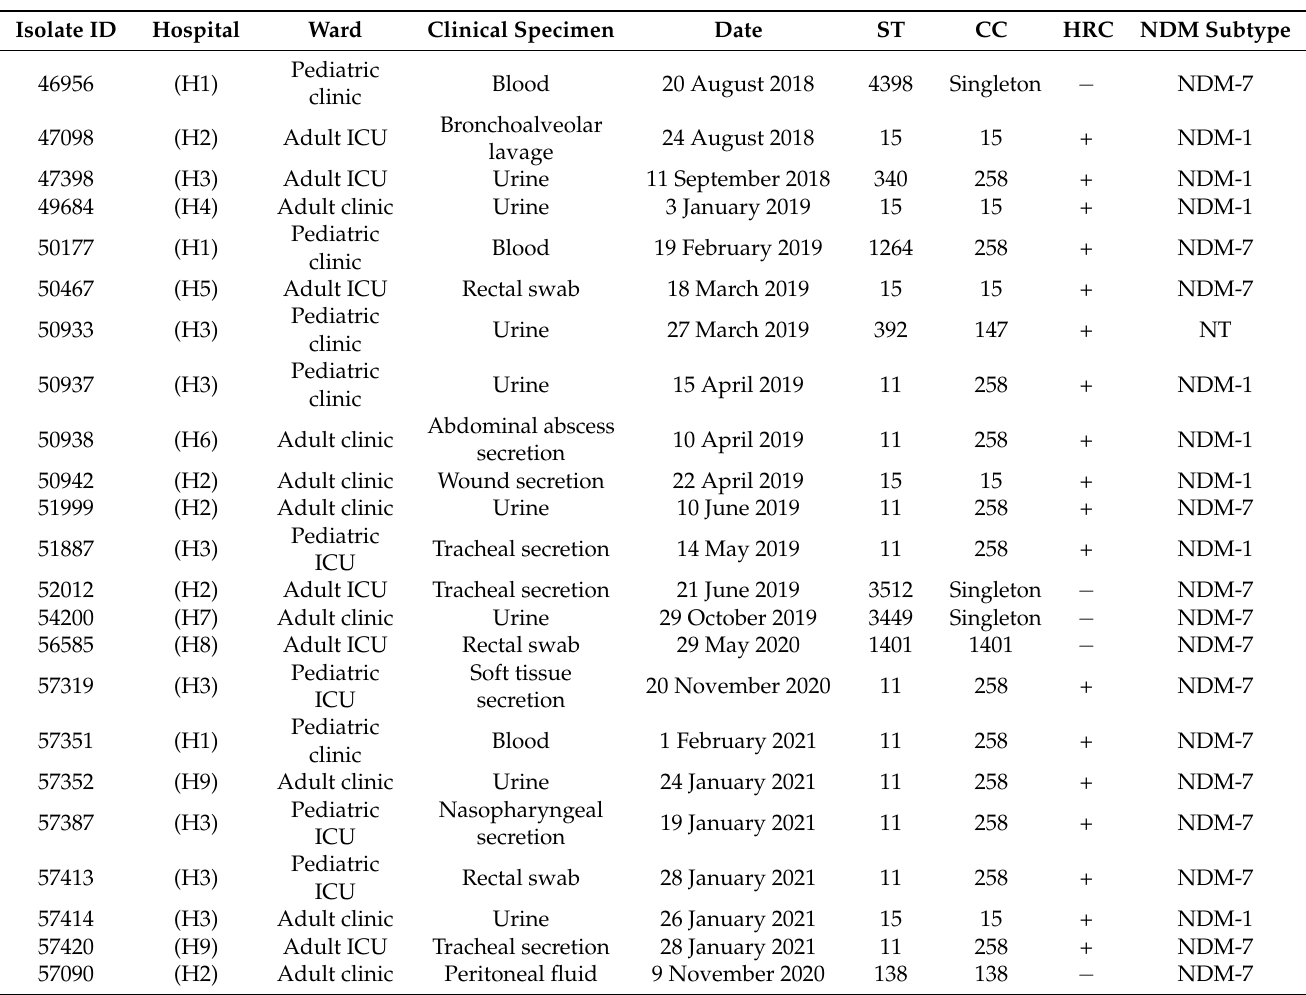
Table 1. Epidemiological and genotyping characteristics of the 23 NDM-producing K. pneumoniae isolates from different healthcare institutions, state of Par á , Brazilian Amazon